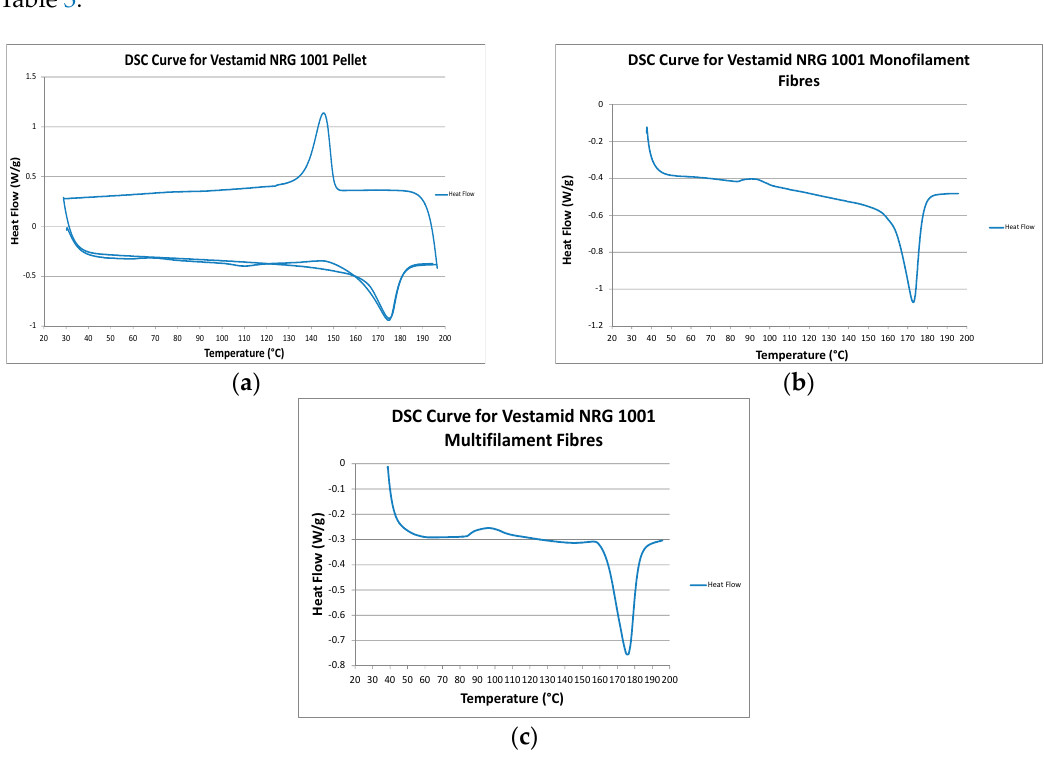
Figure 4. DSC curves for Vestamid NRG 1001 ( a ) Pellets, ( b ) Monofilament fibres, and ( c ) Multifilament fibres.